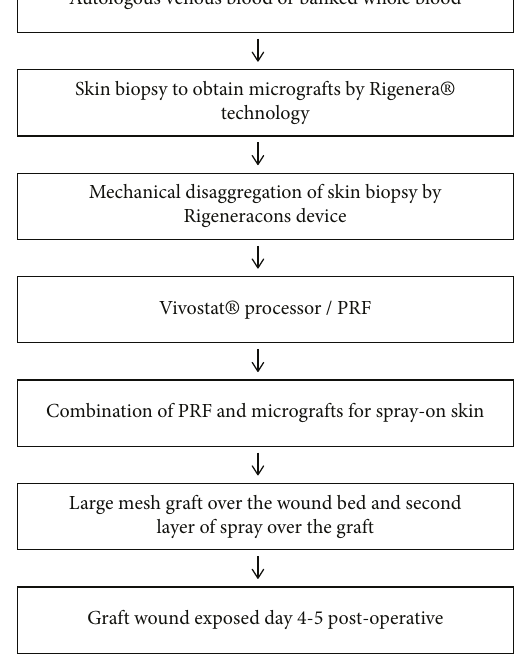
Figure 1: Sampling schedule and steps for the combined technique PRF/micrograft spray-on